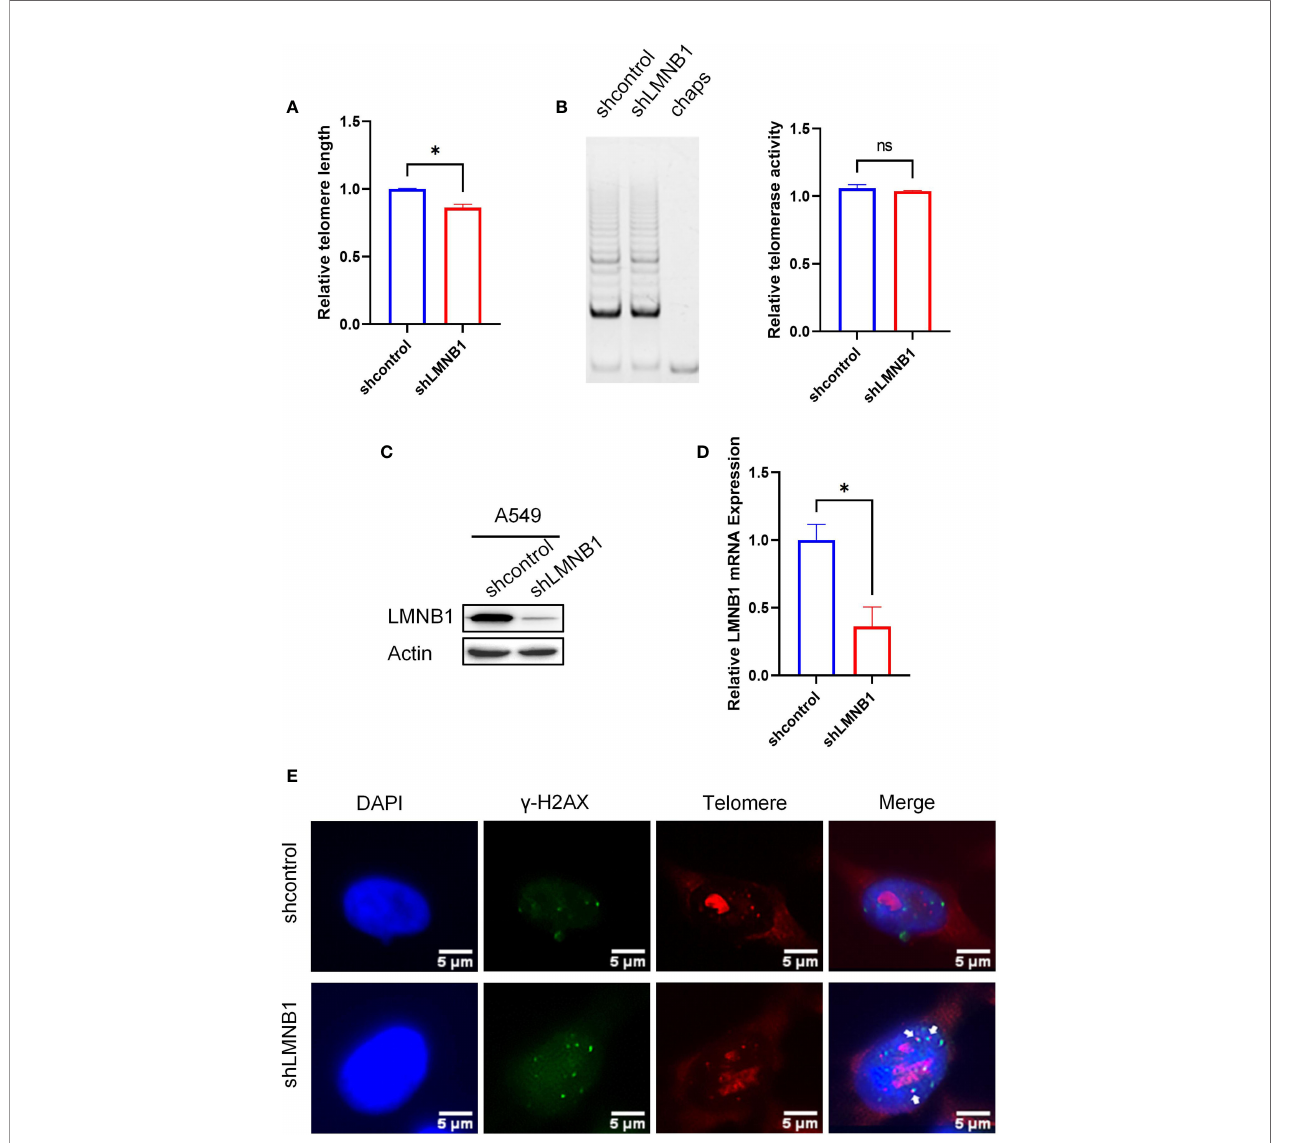
FIGURE 5 | Long-term loss of LMNB1 can cause telomere erosion. (A) WB detected the expression of protein LMNB1, P53, P21, P16 and Actin in A549 siLMNB1 and siNC cells. (B – D) The expression of P53, P21 and P16 mRNA in A549 siLMNB1 cells and the control group were detected by RT-qPCR. (E) The proportion of senescent cells of A549(NCI-1299) siLMNB1 cells and A549 (NCI-1299) siNC cells were detected by SA- b -Gal staining. The percentage of senescence positive cells in each group from fi ve randomly chosen fi elds were calculated. *p<0.05, ns means no signi fi